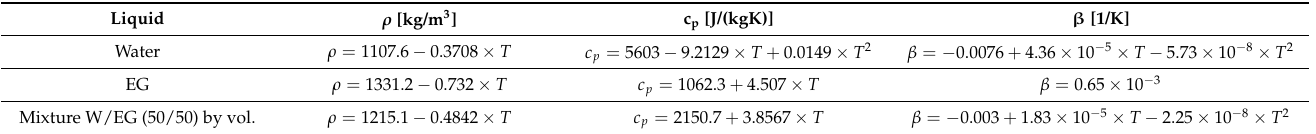
Table 4. Correlations for determination of properties of the tested